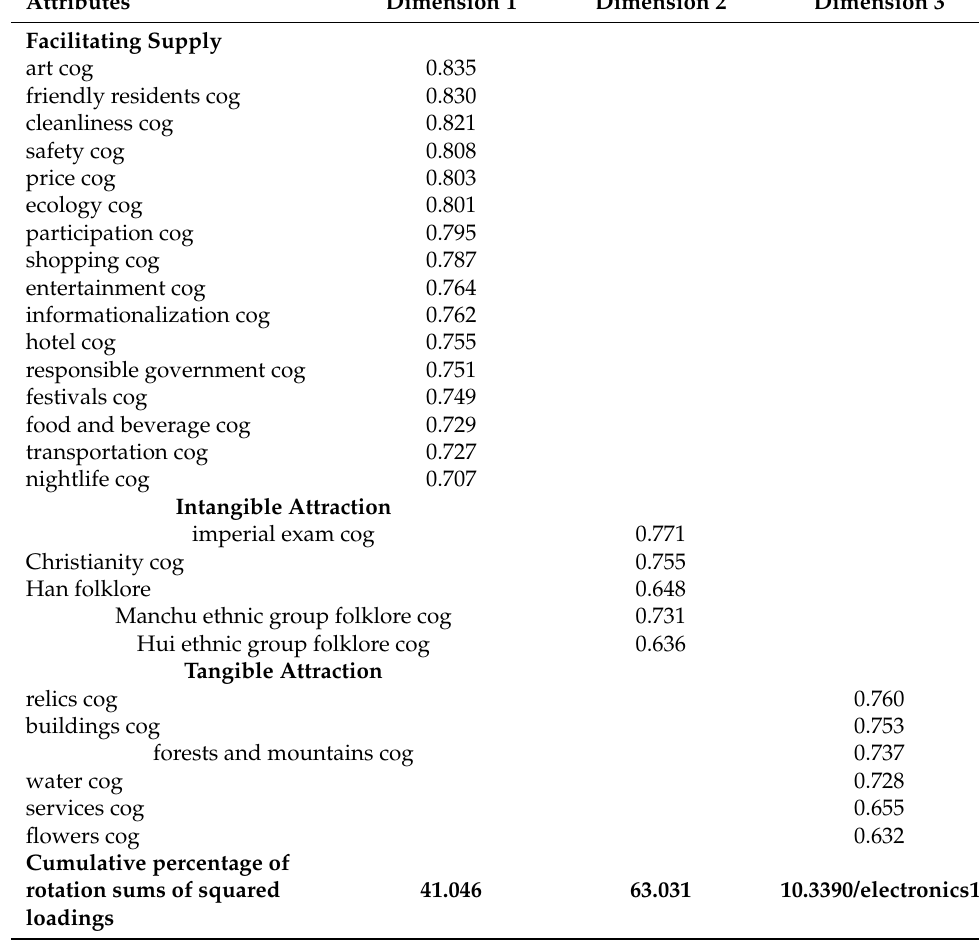
Table 2. EFA of cognition attributes.